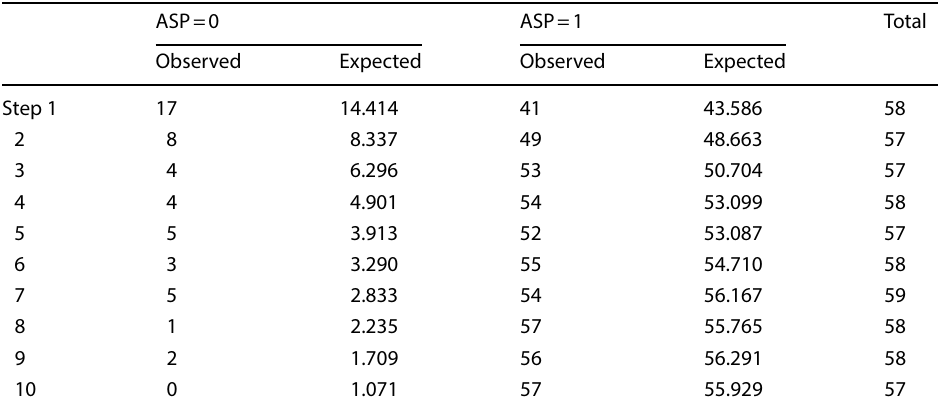
Table 8 Contingency table for Hosmer and Lemeshow Test